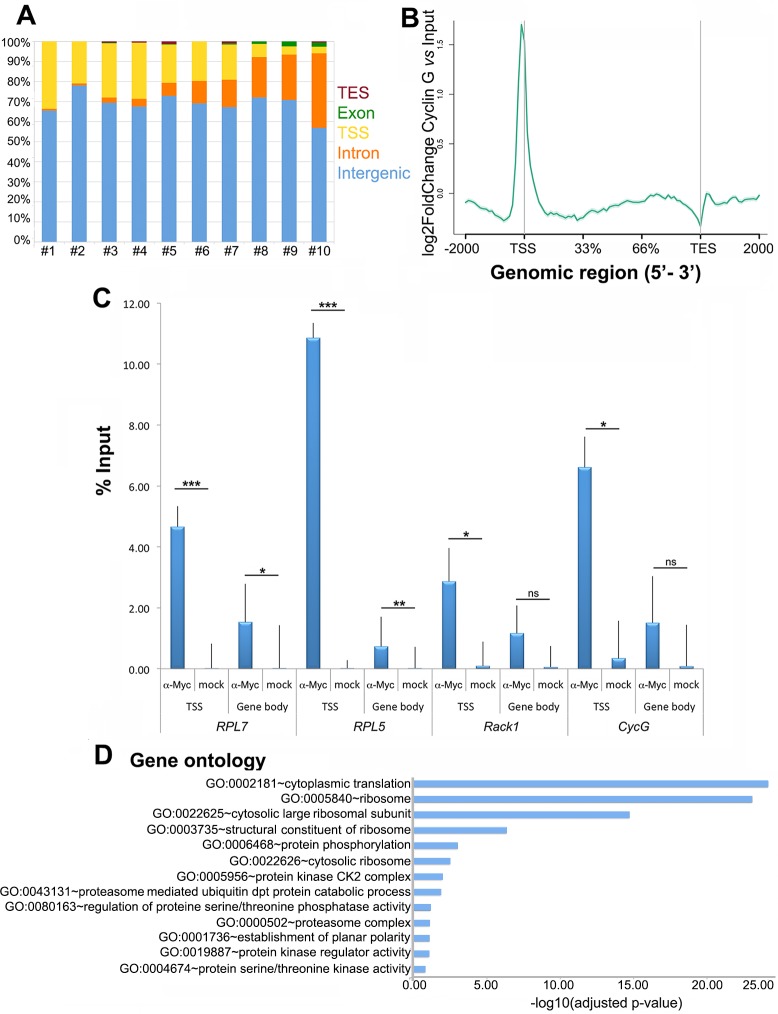
Identification of Cyclin G genome-wide binding sites in wing imaginal
discs.A–Repartition of feature types among the 3363 decile-ranked
Cyclin G peaks (S12 Table). Validated peaks were
ranked based on their height (highest number of overlapping reads), and
separated in ten bins before annotation. B–Average profile
of Cyclin G signal over these genes shown as an aggregation plot. The
standard error is represented as a shaded area over the curve.
C–ChIP-qPCR analysis of RPL7,
RPL5, Rack1 and
CycG. IPs were performed either with Myc antibody
(α-Myc) to reveal the presence of Cyclin G, or with rabbit IgG as
negative control (mock). qPCR were performed using oligonucleotide
primers located either at the TSS or in the gene body as indicated.
Error bars represent the coefficient of variation (CV) (S13
Table). D–Ontology of the 889 genes. Gene
ontology analysis was performed with DAVID.